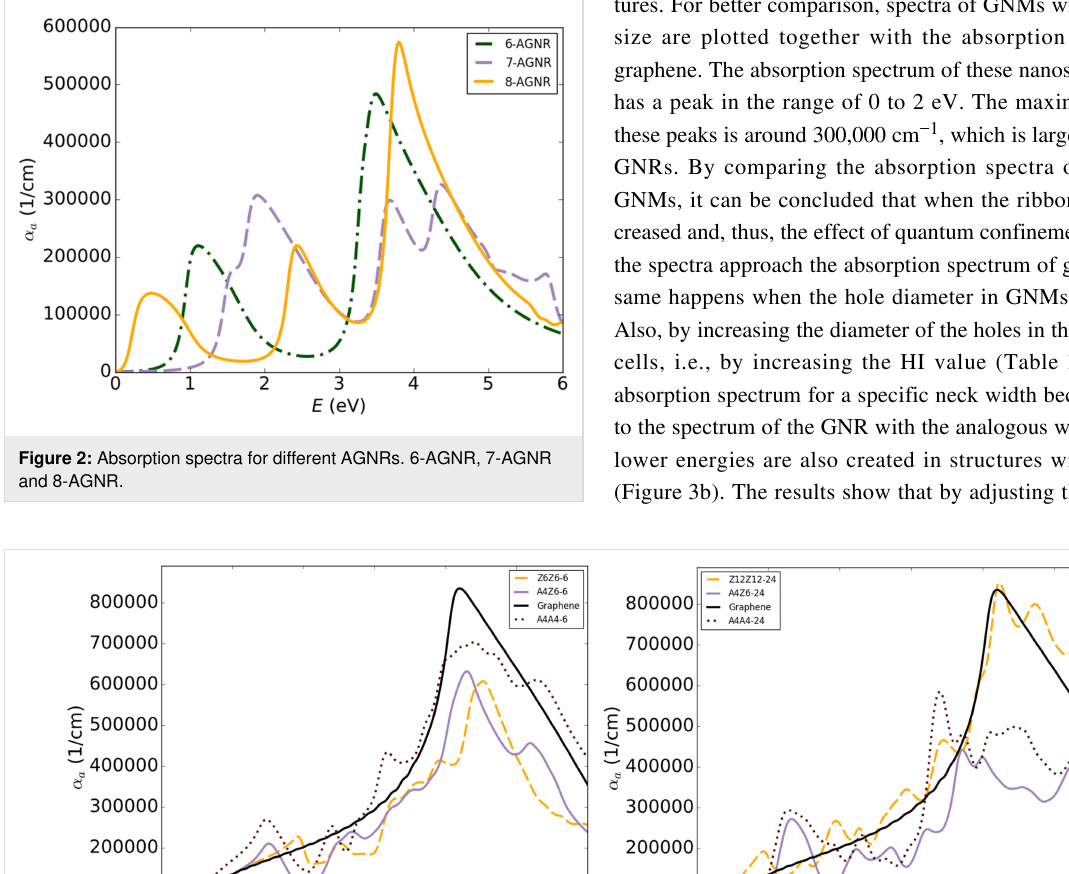
effect of atomic edge disorder can be considerably reduced by means of proper structure design. Efforts have been made to accurately build such